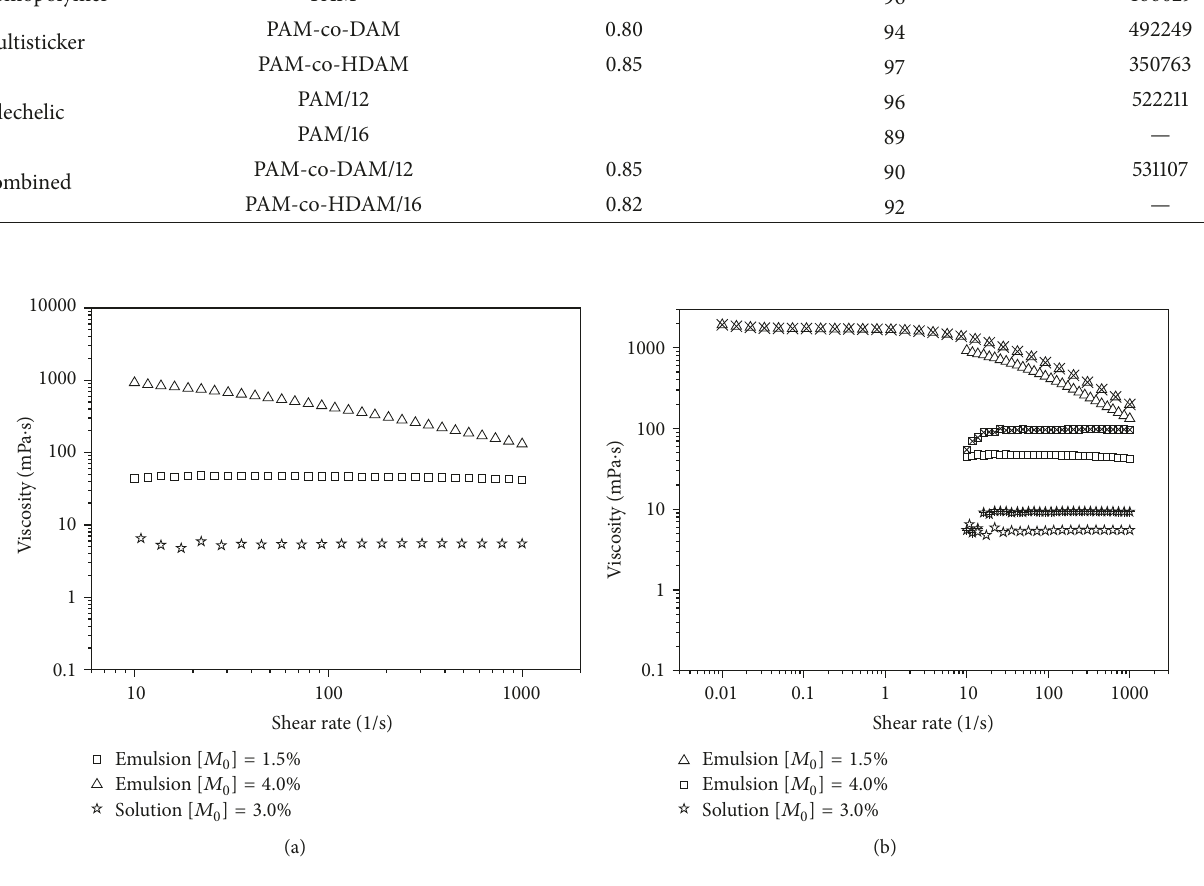
Figure 3: Influence of the polymerization method in the viscosity as a function the shear rate for (a) PAM and (b) HDAM-AM. Polymer concentration 5 wt% for aqueous solutions. Noncrossed symbols correspond to AM homopolymer. [ 𝑀 0 ] = initial monomer concentration.